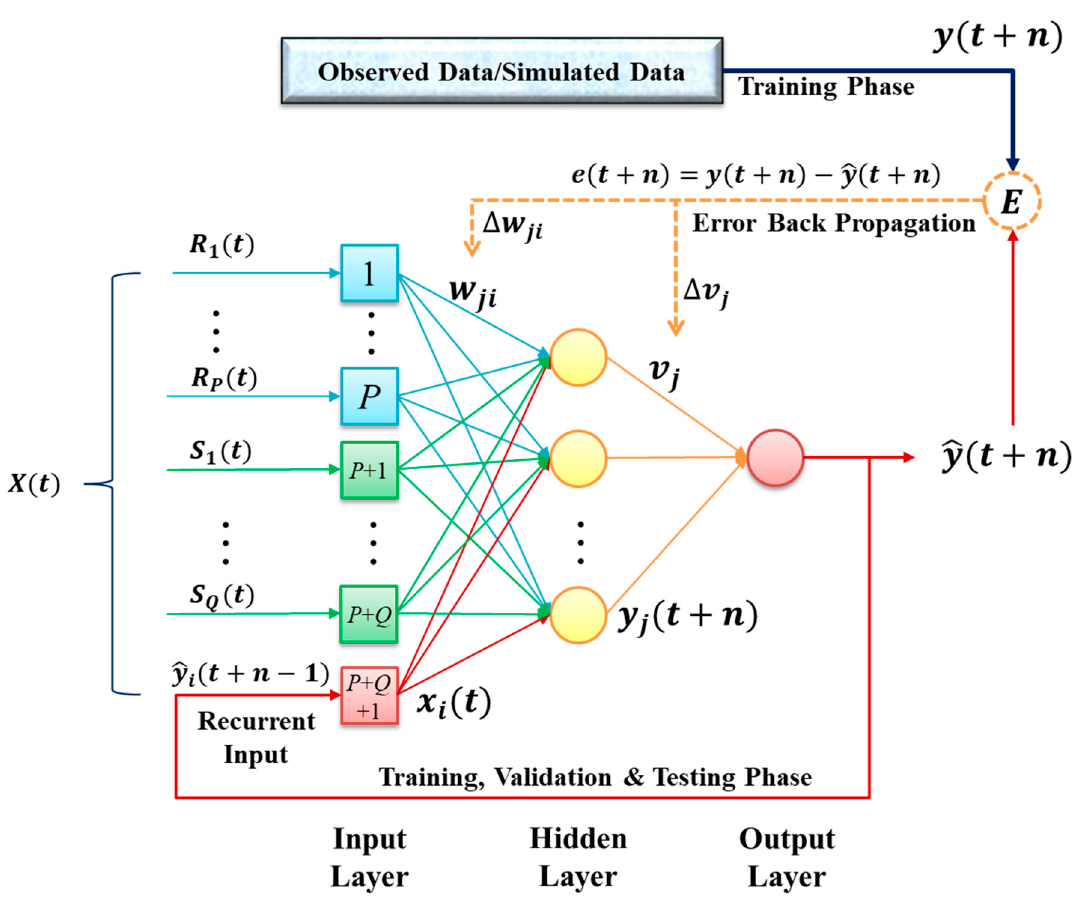
Figure 1. The architecture of the recurrent nonlinear autoregressive with exogenous inputs (RNARX) 109 network. 110